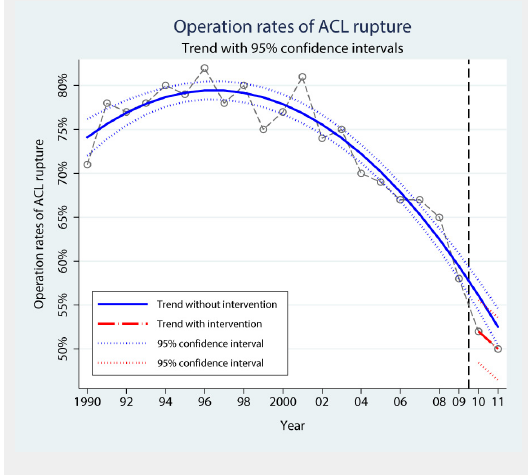
Operation rates of the ruptured anterior cruciate ligament (ACL) over time (1990–2011). Each data point represents the annual operation rate among patients with ruptured ACL (source: SSUV database). Vertical dashed line: Time point of Swiss Medical Board (SMB) report released in 2009. Blue solid trend line: Trend (95% CI) without SMB recommendations up to 2011. Red solid trend line: Trend (95% CI) after release of SMB recommendations in